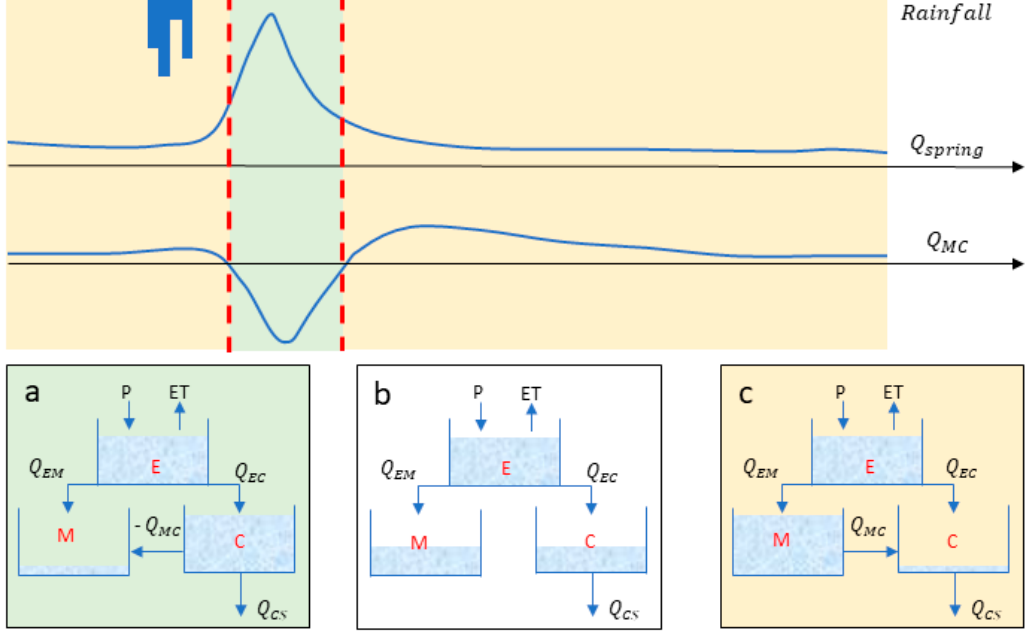
Figure 2. Top : synthetic time series of rainfall, spring discharge ( Q spring ) and matrix-conduit flow dynamics ( Q MC ); Bottom : Structure of the reservoir model: epikarst (E), matrix (M) and conduit (C) are inter-connected from the top to the bottom of the structure. Q MC corresponds to the flow from reservoir M to reservoir C and depends on the difference between water levels in M and C. The model is considered on several time steps: ( a ) the water level is higher in reservoir C, so Q MC < 0; ( b ) the water level in reservoirs C and M are equal, so Q MC = 0 and ( c ) the water level is higher in M so Q MC > 0.